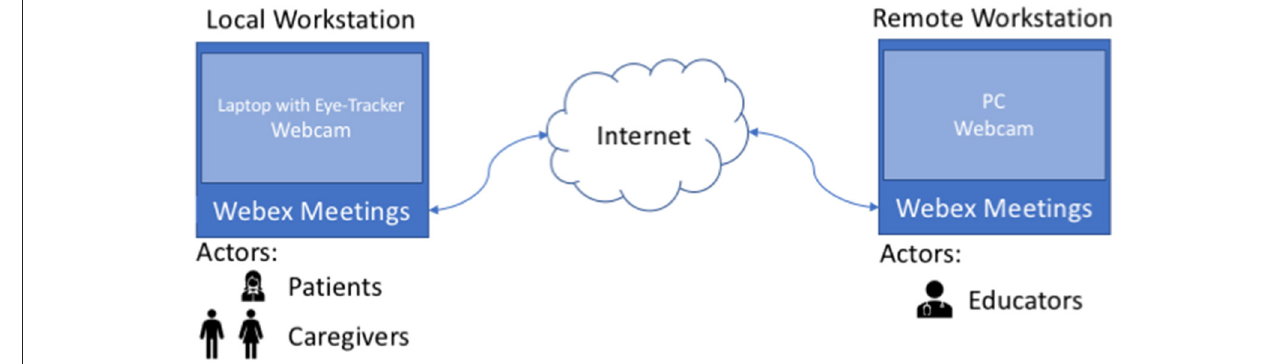
FIGURE 1 | Interactive school architecture.